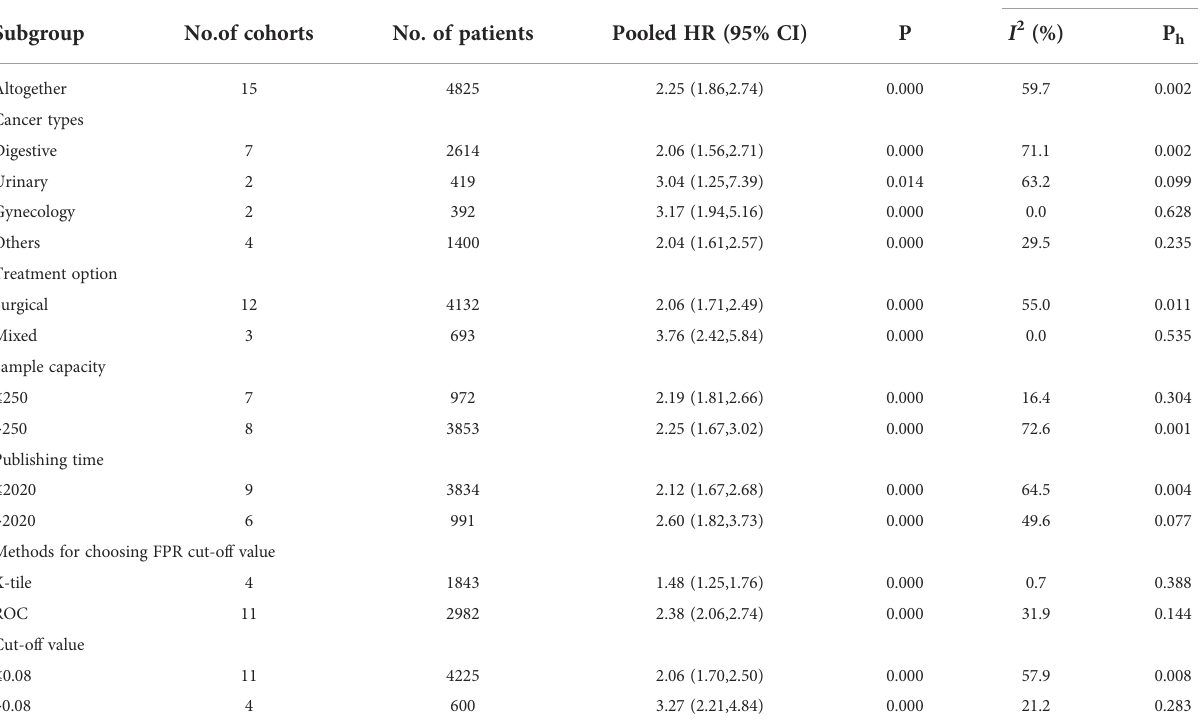
TABLE 3 Subgroup meta-analysis of FAR and